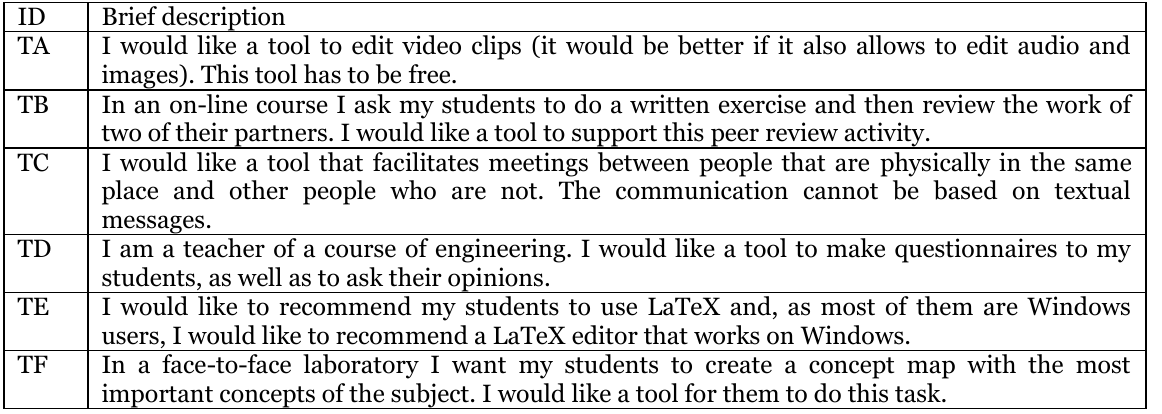
Overview of the Search Tasks used in the Experiment ID Brief